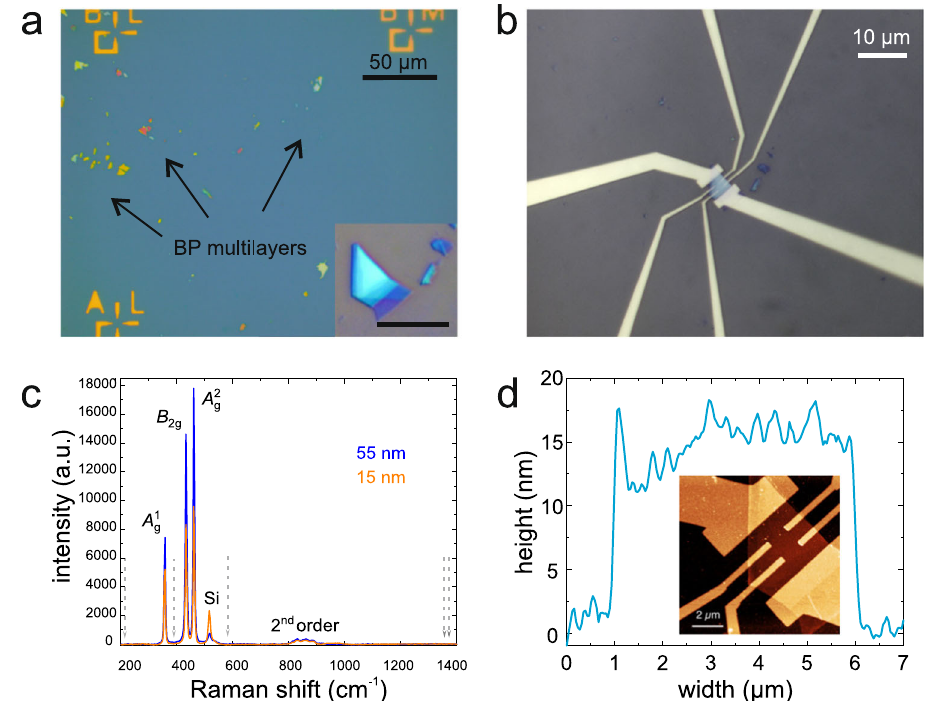
Fig. 1 Mechanical exfoliation and electrical contacting of multilayer BP. Exemplary optical micrographs of a BP fl akes transferred onto the SiO 2 -coated silicon substrate. Inset: single BP fl ake (scale bar 10 μ m). b A fl ake after electrical contact with Ti/Au electrodes in a 4-point con fi guration. Large electrodes are current-carrying leads, side electrodes are 4-point voltage probes (cf. “ Methods ” ). c Raman spectrum of two fl akes of different thicknesses after device processing. Only the common BP signature lines A g1 , B 2g and A g2 and the intrinsic BP second- order Raman response (ca. 790 – 920 nm − 1 range) are observed (Si line from the substrate as expected at 520 cm − 1 ). No trace of other lines associated with oxidation or degradation is present. The expected positions of theoretically predicted prominent oxidation lines are indicated by the arrows 28,29 . d Flake height pro fi le extracted from an atomic force micrograph (inset) after electrical characterisation. The extracted fl ake height is (15.1 ± 1.8) nm corresponding to (29 ± 3) phosphorene